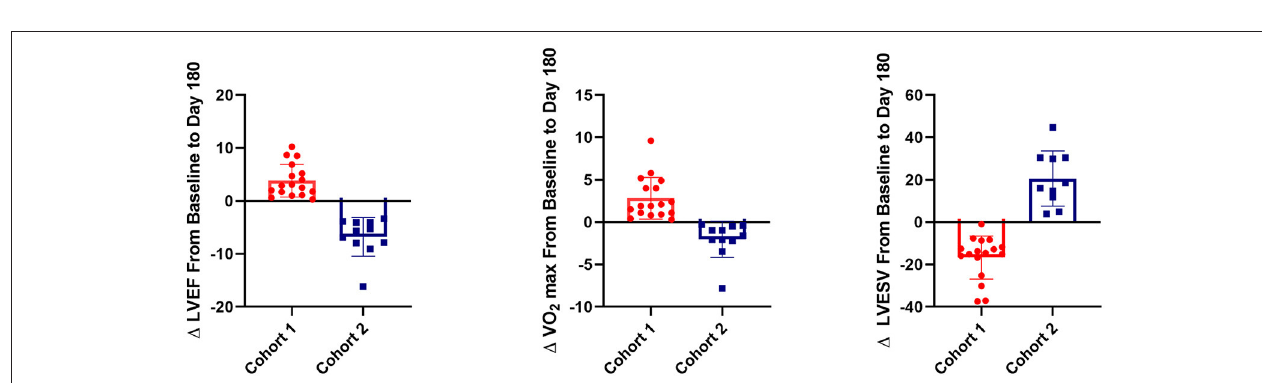
FIGURE 3 | 3D plot of change in left ventricular ejection fraction (LVEF), left ventricular end-systolic volume (LVESV), and VO 2 max between baseline and post-operative day 180 in the two cohorts from the FOCUS-CCTRN trial. Cohort 1 showed an increase in LVEF ( p < 0.001) and VO 2 max ( p < 0.001) and a decrease in LVESV ( p < 0.001) when compared with cohort 2. Percentage of CD45 + CD19 + cells at baseline is represented by the size of circles. Larger circles indicate a higher percentage of CD45 + CD19 + cells, and smaller circles indicate a lower